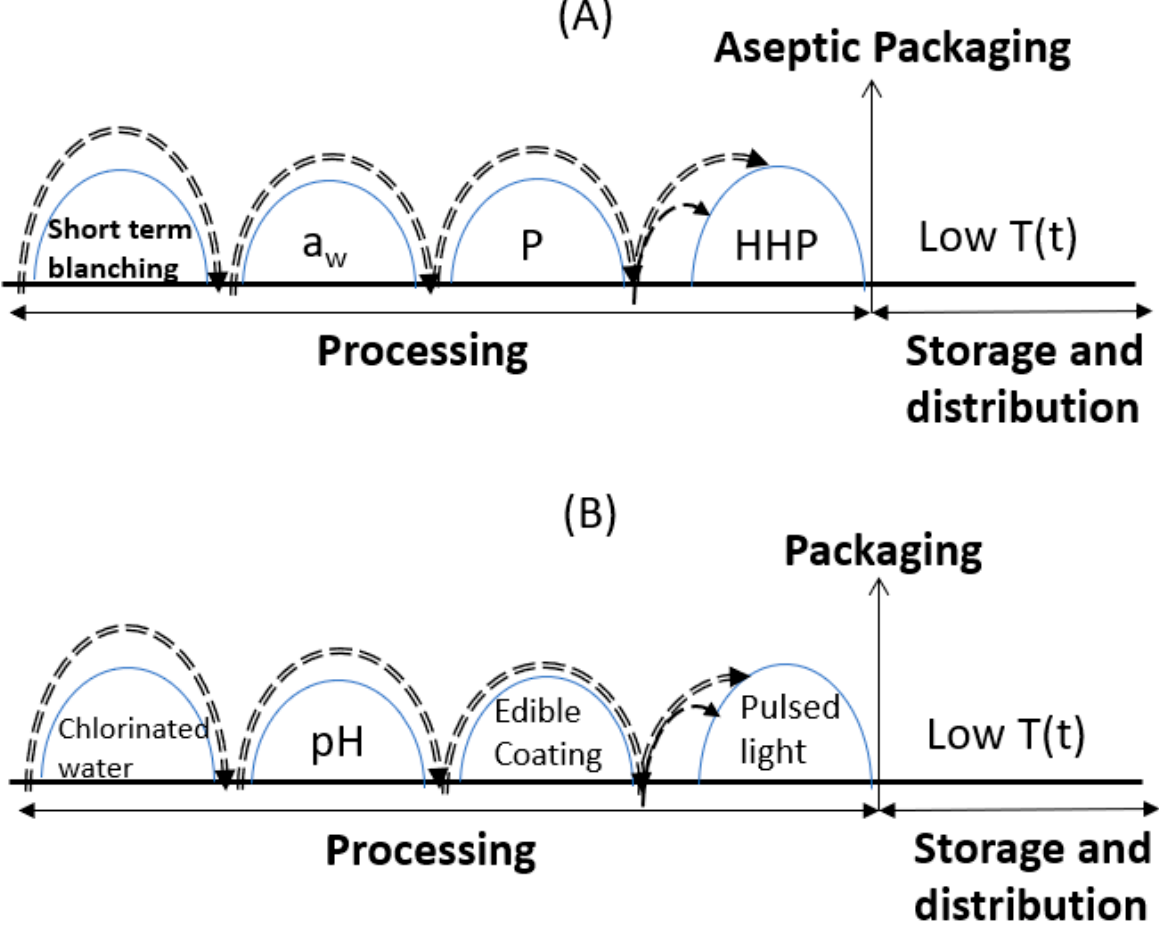
Figure 2. Indicative examples of the hurdle concept on the preservation of fruits, based on ( A ) Dermesonlouoglou et al. [59] and ( B ) Moreira et al. [56].